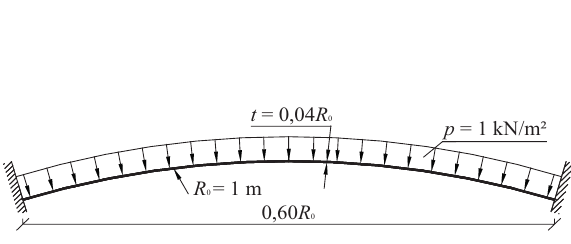
Fig. 4. A computational scheme of an elastic spherical shell